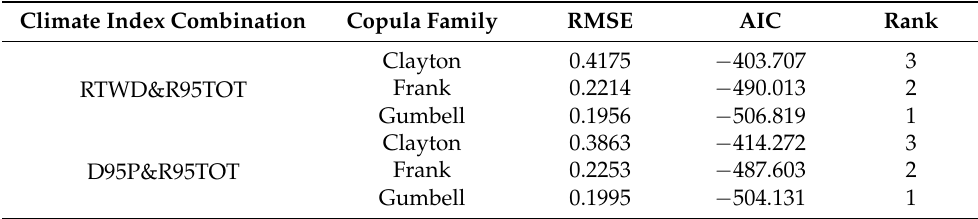
Table 4. Ranking of copula families based on RMSE and AIC